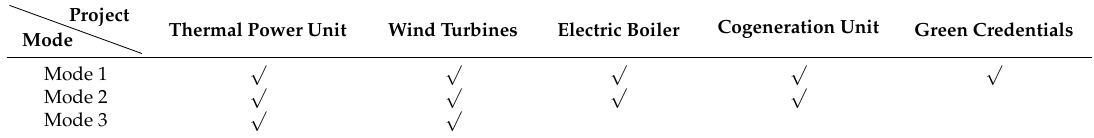
Table 4. Unit combination